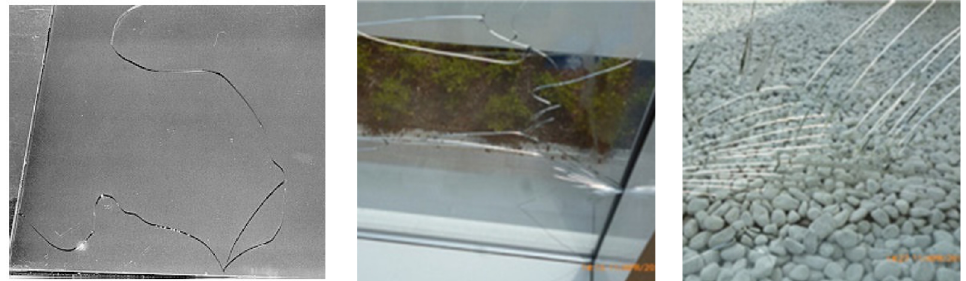
Figure 6. Example of glass panes with cracks due to climatic-induced thermal shock (figures repro- duced from [60,121] with permission from Elsevier©, copyright license agreement n. 5507161319840, March 2023).